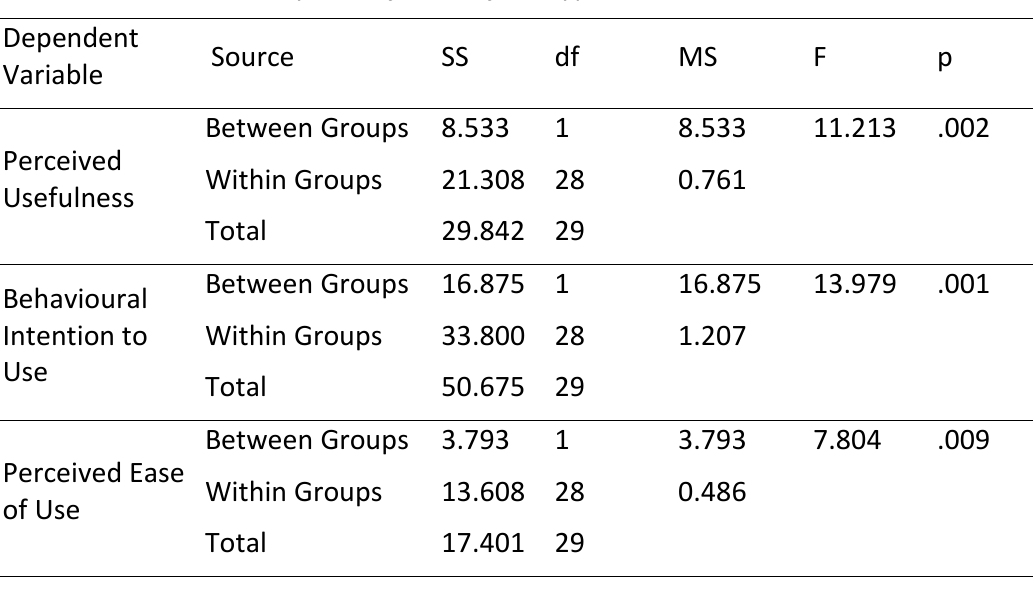
Table 3. ANOVA Summary Table for Interface